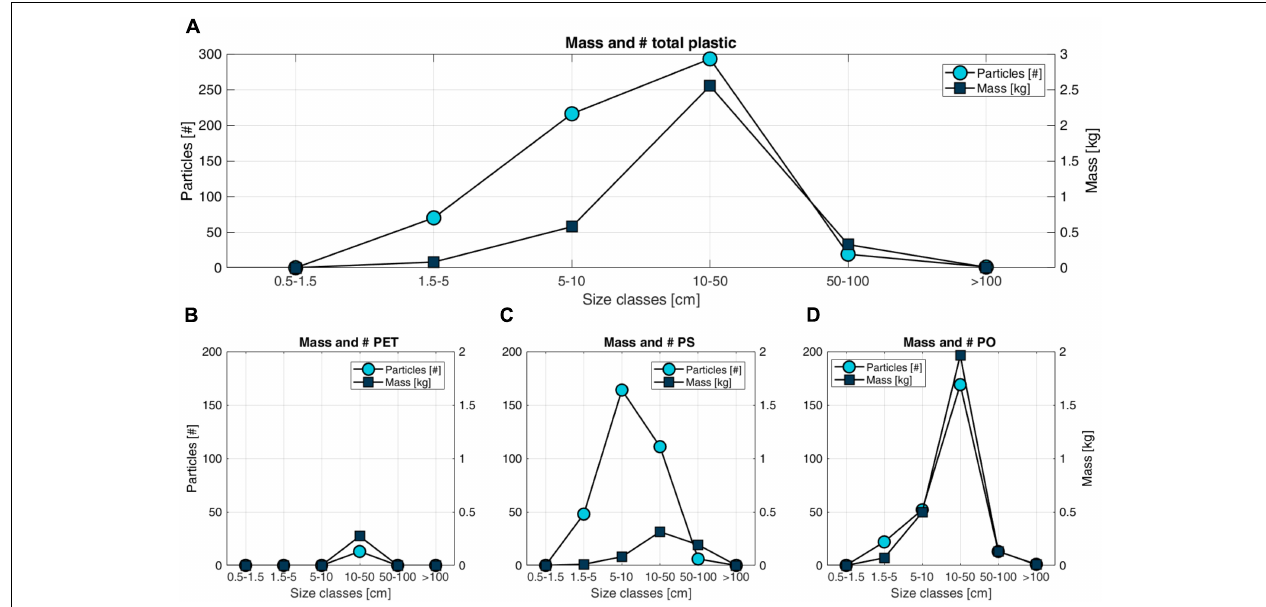
FIGURE 4 | Mass and number of pieces per size class for (A) all plastic, (B) PET, (C) PS, and (D) PO.